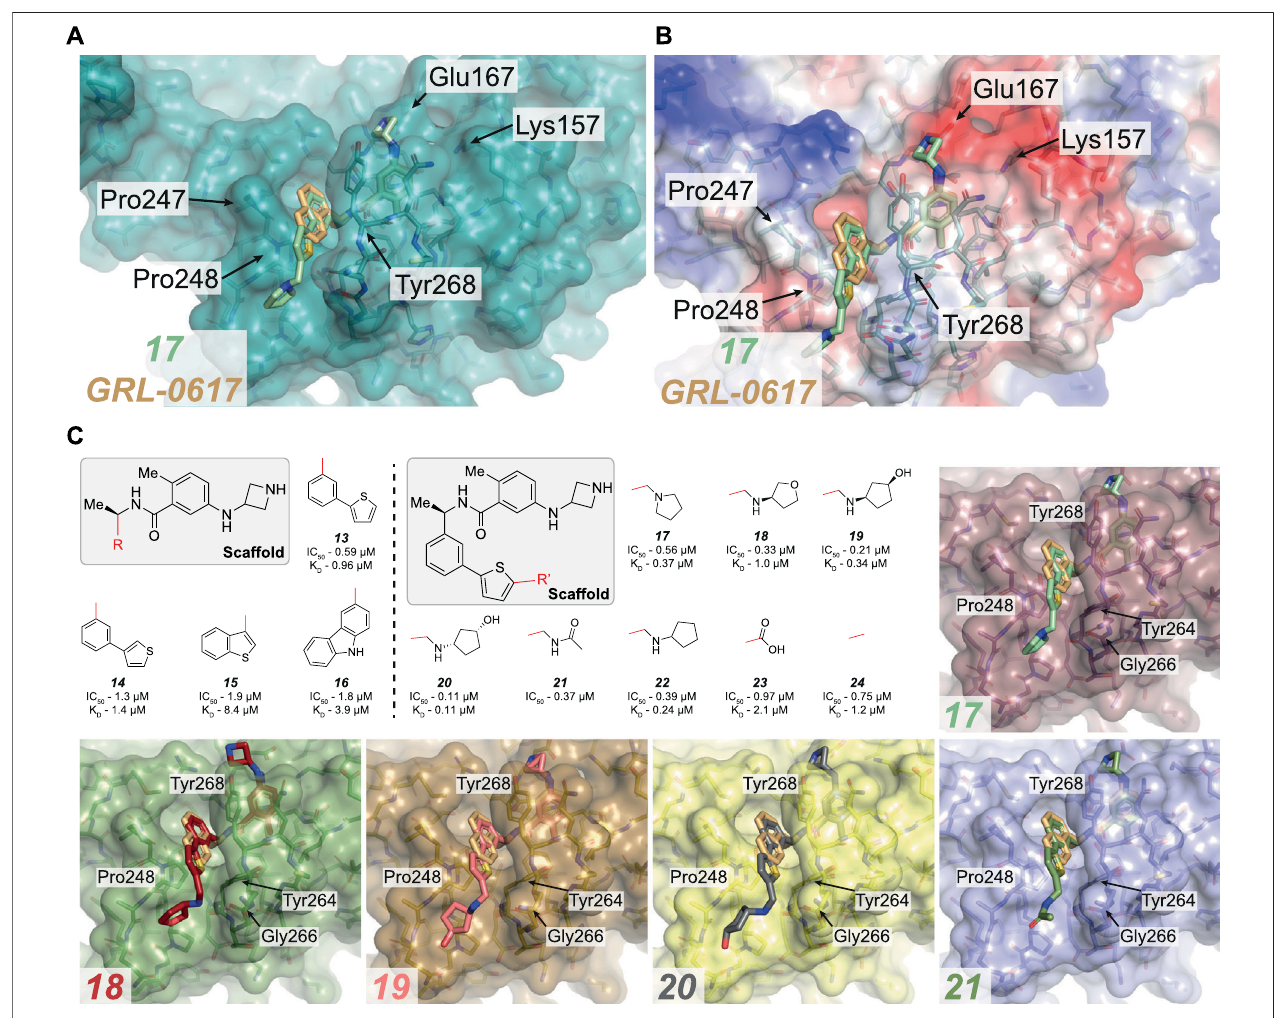
FIGURE4| Overviewofcompoundswhichsuccessfullyreplacedthenaphthylringin GRL-0617 . (A,B) Closeupviewofthe GRL-0617 bindingpocketwithPLpro represented in teal in cartoon representation overlaid with the surface representation (A) or calculated surface charge of the protein (B) . GRL-0617 in wheat colour and compound 17 in green are depicted in ball and stick representation. In (A) the key residues are noted to highlight the BL2 groove formed by closure of the blocking loop and induced upon ligand binding. 17 shows that the replacement of the naphthalene ring with a 2-phenylthiophene appears to effectively replace the dependency of the naphthyl group. The BL2 groove is then engaged by a basic amine tail to improve potency. (C) Boxed (left), the parent scaffold for modifying the naphthyl group. Boxed (right) Second iteration of compound designs, starting at the 2-phenyl thiophene scaffold ( 13 ). The red line indicates the handle used for the respective substitution. Compound data refer to IC 50 from in vitro activity assays, and K D values from SPR where available (see Table 3 for the compound identi fi ers from their respective publications). 13 – 16, the 2-phenyl thiophene appears to successfully replace the naphthyl ring while still maintaining potency. 17 – 24 , Aromatics containing basicaminesappear tobethemostpotentat thisposition. Co-crystal structures for 17 – 21 areshown [PDBIDs, 17 (7LBS), 18 (7LOS), 19 (7LLF), 20 (7LBR), 21 (7LLZ)]. In the case of 17 , the basic nitrogen interacts with residues lining the BL2